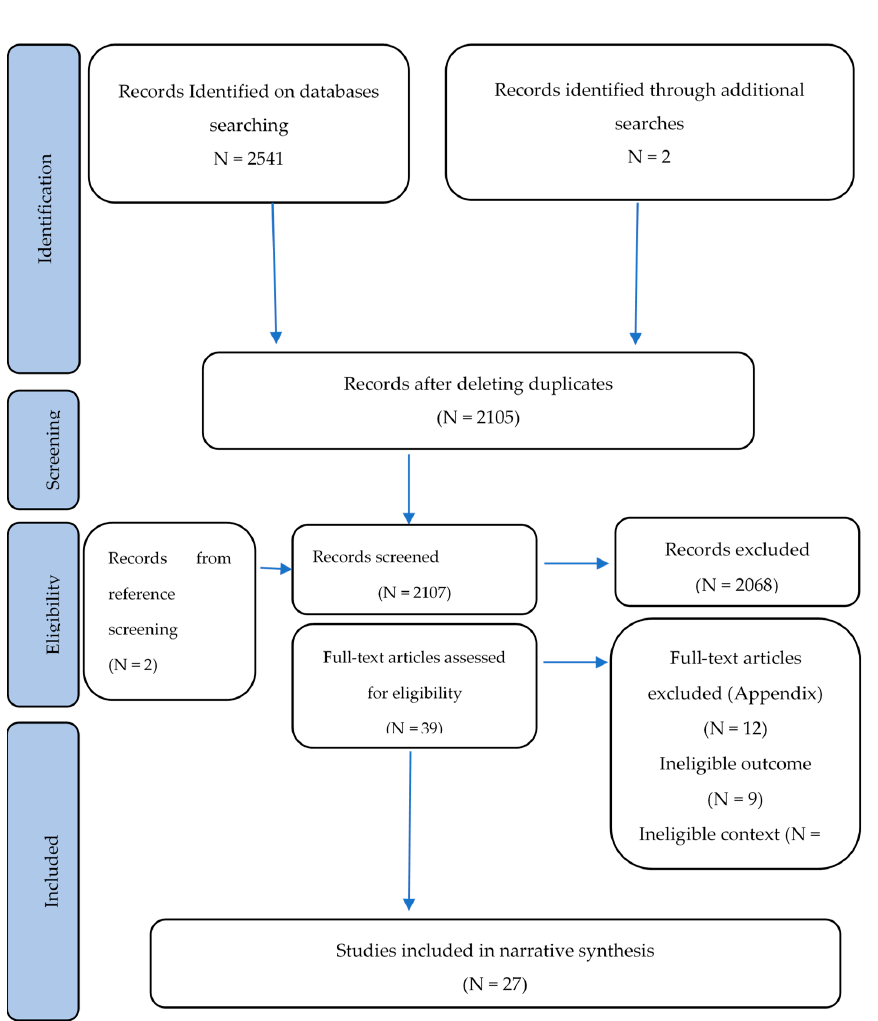
Figure 2. Flow diagram for the scoping review process adapted from the PRISMA statement by Moher and colleagues [41].